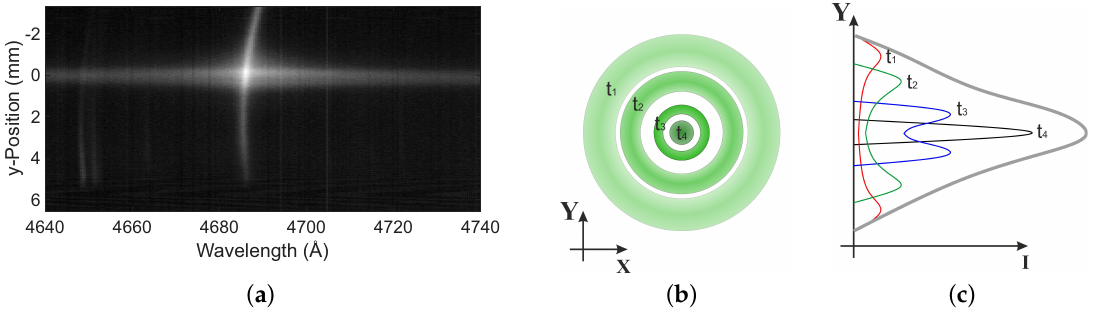
Figure 2. ( a ) Spectral image of the time and space integrated He II P α line, ( b ) sketch of different stages of the compressing plasma channel, and ( c ) spatially (along x ) integrated intensity profiles originating at different times from the compressing plasma channel and the time-integrated profile (the thick gray